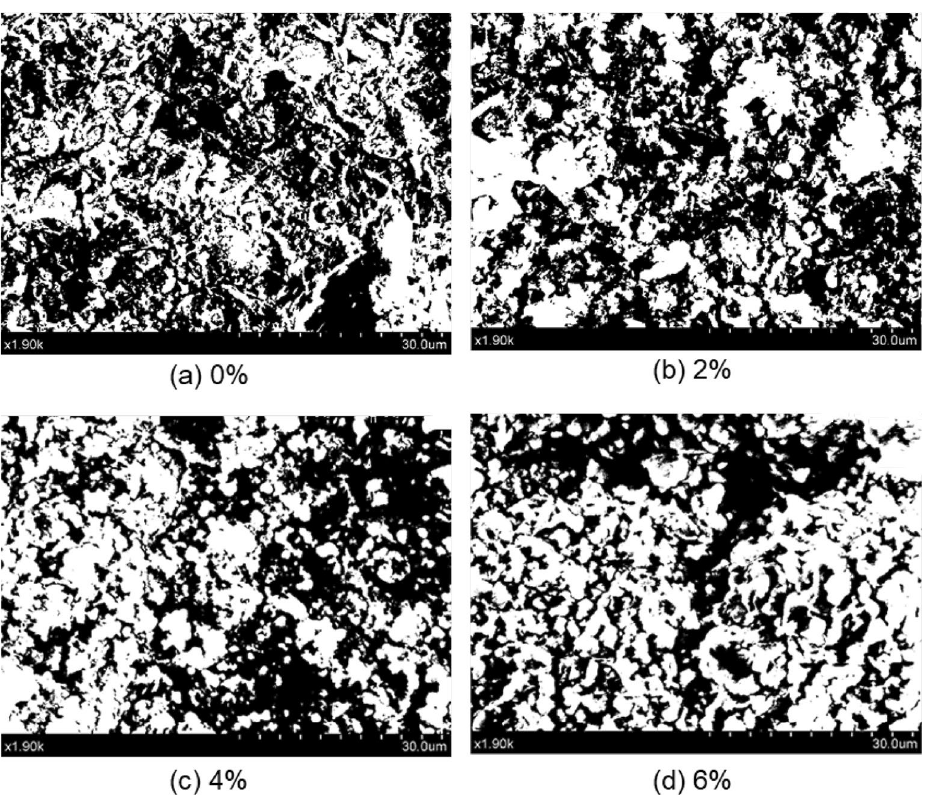
Figure 13. Binary images of soft marine clay with different salinities.